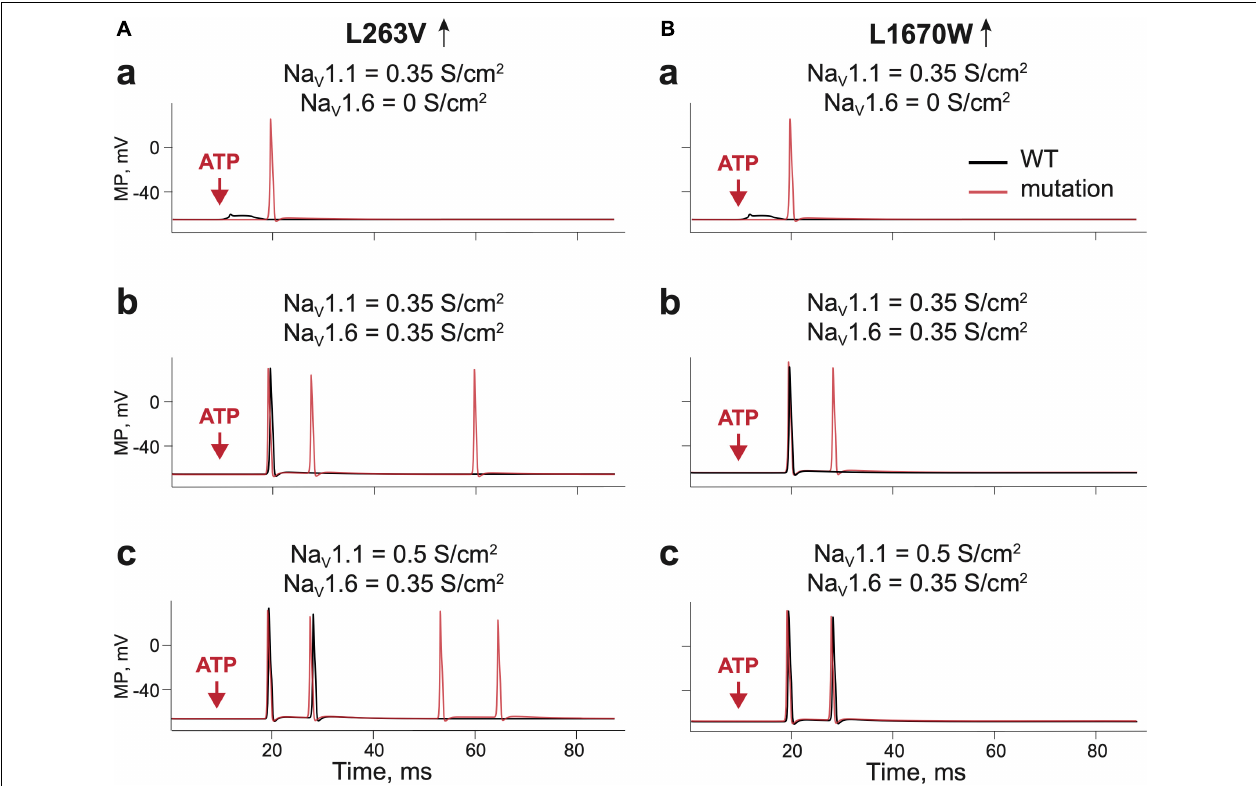
FIGURE 3 | Testing the role of Na V 1.1 and Na V 1.6 in firing of A δ -fiber with one branch and a single ATP release event. (Aa) The receptor potential in a single WT (Kahlig et al., 2008) fiber expressing Na V 1.1 (black line) and firing in the fiber without Na V 1.6. with L263V mutation (red line) of Na V 1.1 with conductance 0.35 S/cm 2 . Of note, there is a membrane potential in the nerve compartment, where ATP is acting, whereas in other panels we present the appearance of the signal to the trigeminal ganglion. (Ab) WT (Kahlig et al., 2008) fiber (black line) and the L263V mutation (red line) with Na V 1.1 and Na V 1.6 (both with conductance 0.35 S/cm 2 ) and; (Ac) WT (Kahlig et al., 2008) fiber (black line) and the L263V mutation (red line) with Na V 1.1 conductance 0.5 S/cm 2 and Na V 1.6 conductance 0.35 S/cm 2 . (Ba) The receptor potential in a single WT (Dhifallah et al., 2018) fiber (black line) and L1670W mutation (red line) of Na V 1.1 conductance 0.35 S/cm 2 and without Na V 1.6. (Bb) WT (Dhifallah et al., 2018) fiber (black line) and the L1670W mutation (red line) with Na V 1.1 conductance 0.35 S/cm 2 and Na V 1.6 conductance 0.35 S/cm 2 . (Bc) WT (Dhifallah et al., 2018) fiber (black line) and the L1670W mutation (red line) with Na V 1.1 conductance 0.5 S/cm 2 and Na V 1.6 conductance 0.35 S/cm 2 . ATP signaling is limited by partial